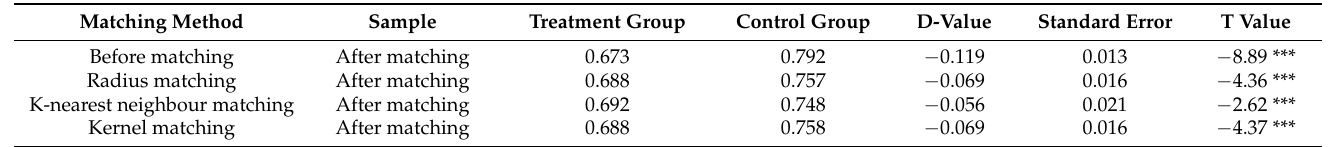
Table 5. Processing of the PSM method.